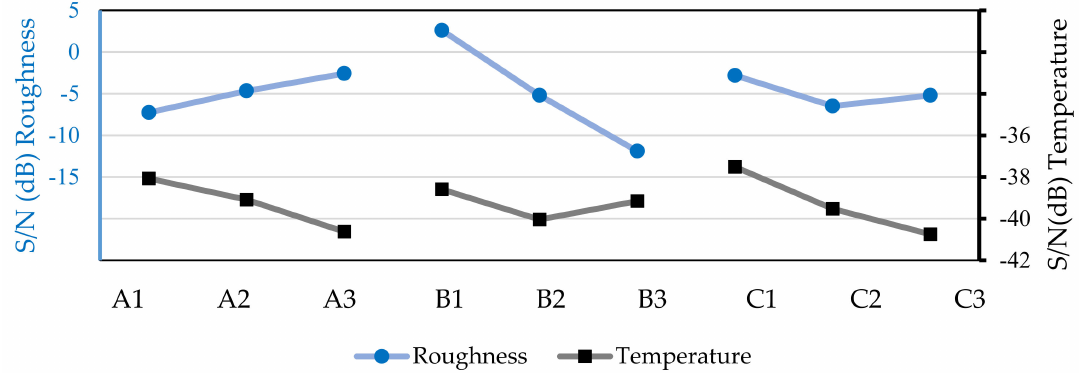
Figure 8. S/N values for surface roughness of the workpiece and chip temperatures based on the machining tests with vegetable oil (50